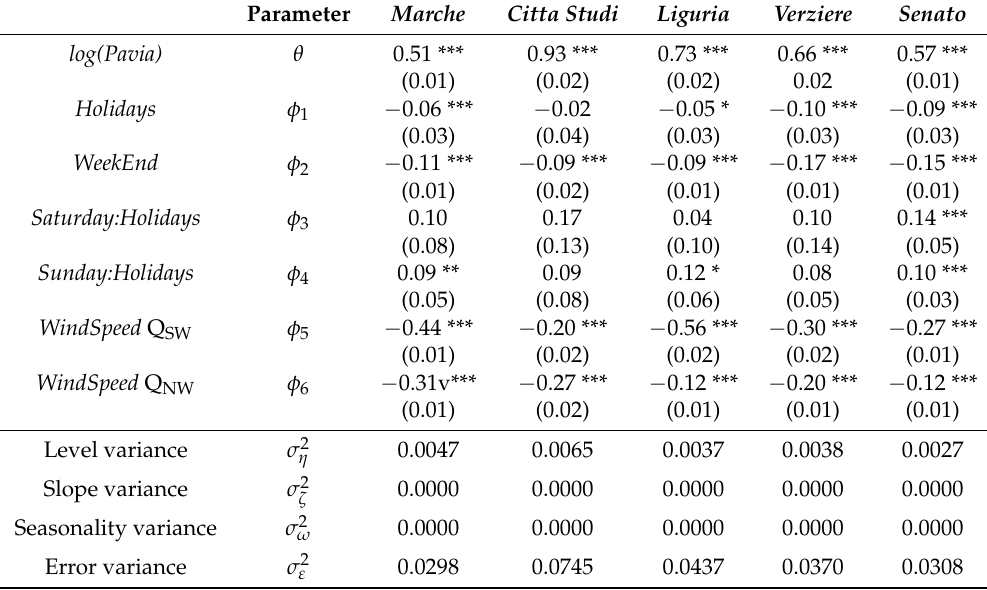
Table 4. ML estimates of BSM parameters and variances for NO x .